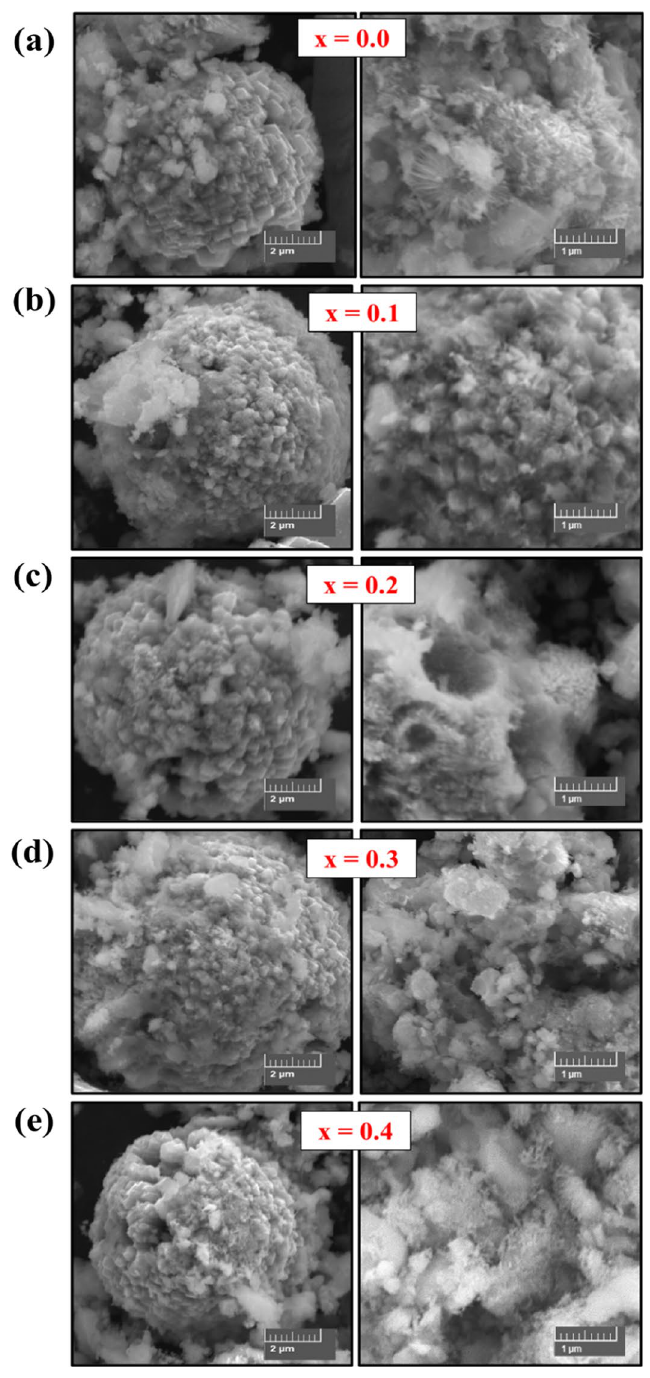
Figure 2. SEM microstructural images of V x -MnCo samples for (a) without V doping followed by x = (b) 0.1, (c) 0.2, (d) 0.3, and (e) 0.4 at different